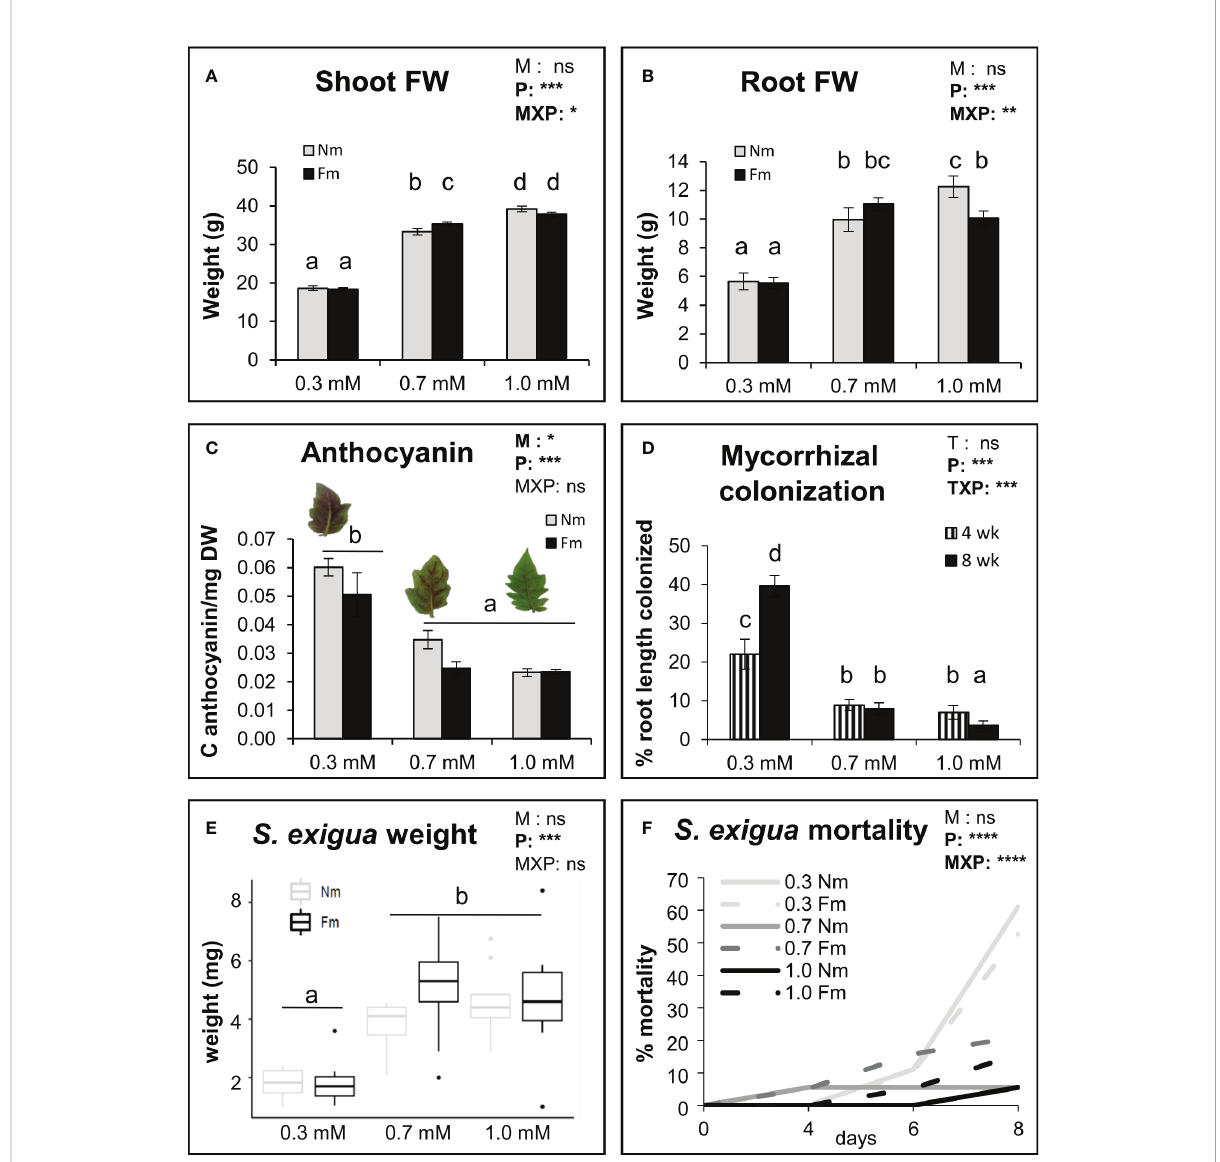
FIGURE 1 Impact of P levels on plant growth, AM colonization and herbivore performance. Plant growth parameters, fungal colonization and herbivore performance on non-mycorrhizal (Nm) and mycorrhizal tomato plants colonized by Funneliformis mosseae (Fm). Plants were fertilized with different P concentrations: 0.3 mM, 0.7 mM and 1mM of H 2 NaPO ₄ . (A) Shoot and (B) root fresh weight (n=10), and (C) anthocyanin content (n=6) were determined in tomato plants at harvest, 8 weeks post mycorrhizal inoculation (pmi). (D) Percentage of root length colonized by the mycorrhizal fungi at 4 and 8 weeks pmi (n=10). One leaf per plant was detached 8 weeks pmi and infested with 2 second instar S. exigua larvae (n=20), and (E) weight of the larvae was determined after 6 days of feeding. (F) Larval mortality was monitored during 8 days of continuous feeding on the detached tomato leaves. Data from A to E represent means of the n independent biological replicates ± SD. Two-way factorial ANOVA (A – C, E, F) using AM symbiosis (M) and P treatments (P) as factors, or (D) using time (T) and P treatments (P) as factors were performed, and signi fi cance values of each factor and their interactions are indicated in the upper right corner of each graph. Asterisks denote signi fi cant effect of a factor and their interaction. ns: no signi fi cant; *: p < 0.5; **:p < 0.01; ***:p < 0.001; ****:p < 0.0001. Different letters represent statistically signi fi cant differences (ANOVA, Fisher ’ s Least Signi fi cant Difference (LSD) test; p<0.05). For (F), data represent the percentage of mortality at the different time points, and the differences in the survival distribution according to P, M and MxP were performed using the non- parametric Log-rank (Mantel-Cox)